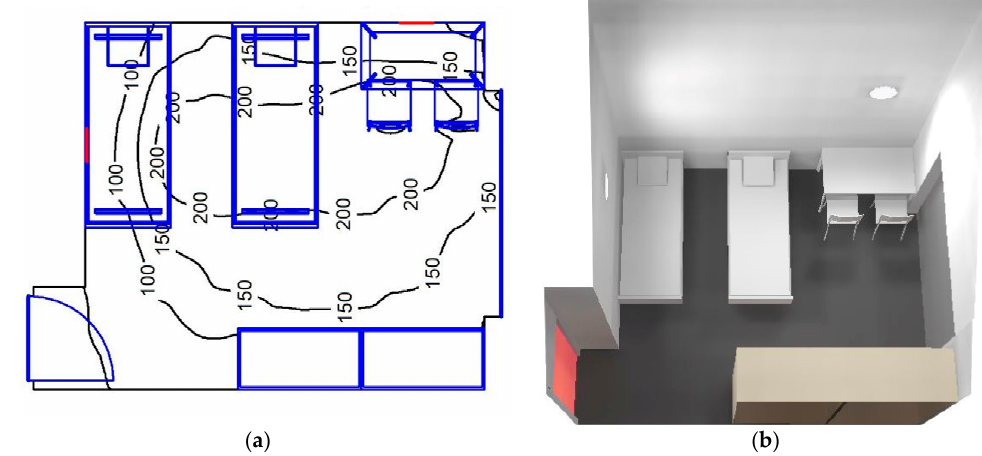
Figure 6. Distribution of illuminance in Bedroom 2: ( a ) plan and ( b ) perspective view. Figure 7. Distribution of illuminance in Bedroom 2: ( a ) plan and ( b ) perspective